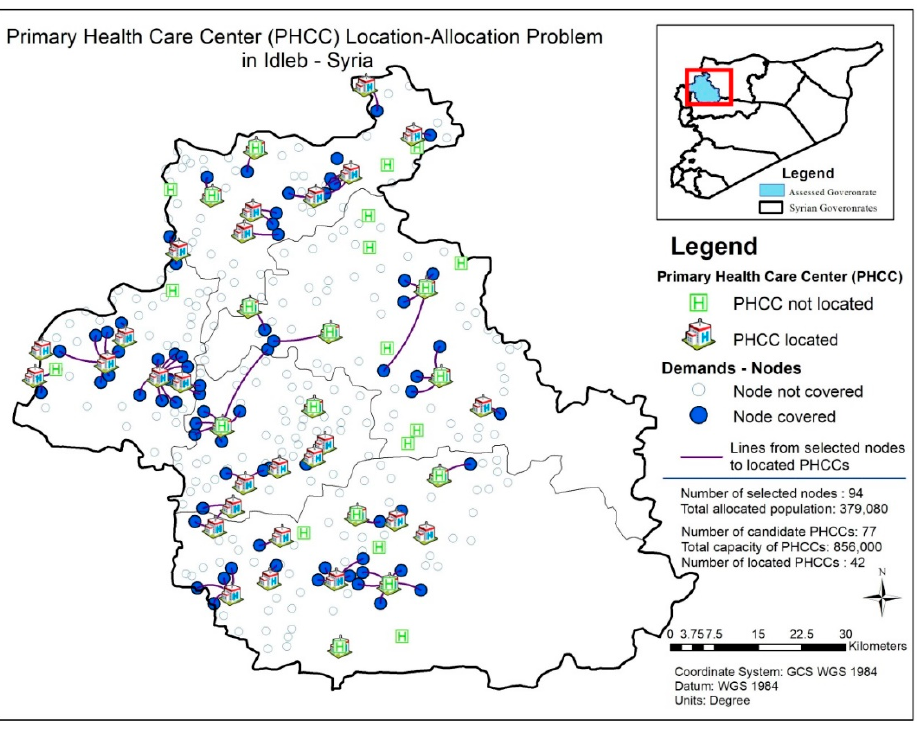
Figure 5. Results of the PHCC location-allocation problem addressed in the study.